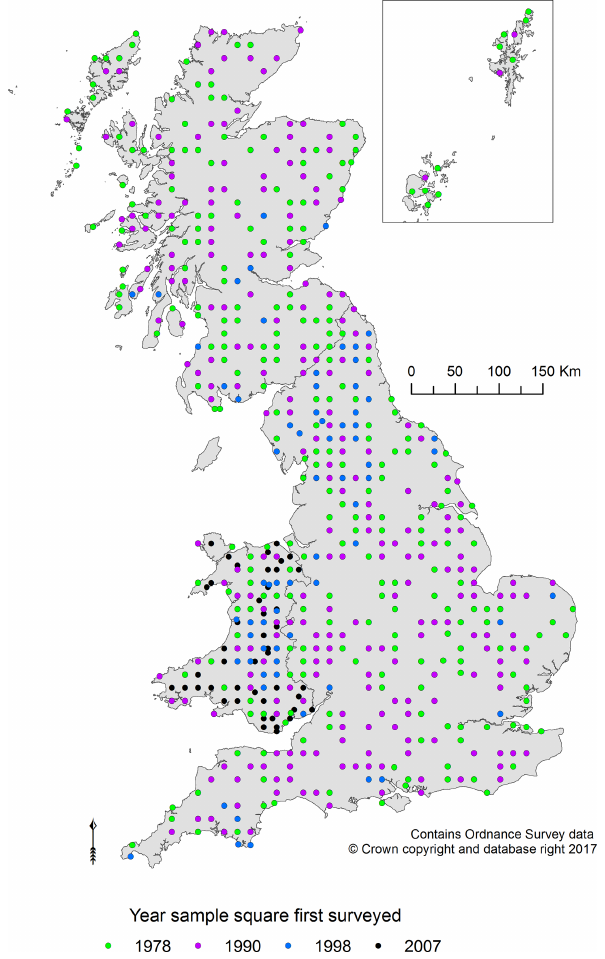
Figure 2. Map of Countryside Survey sampling locations across Britain.